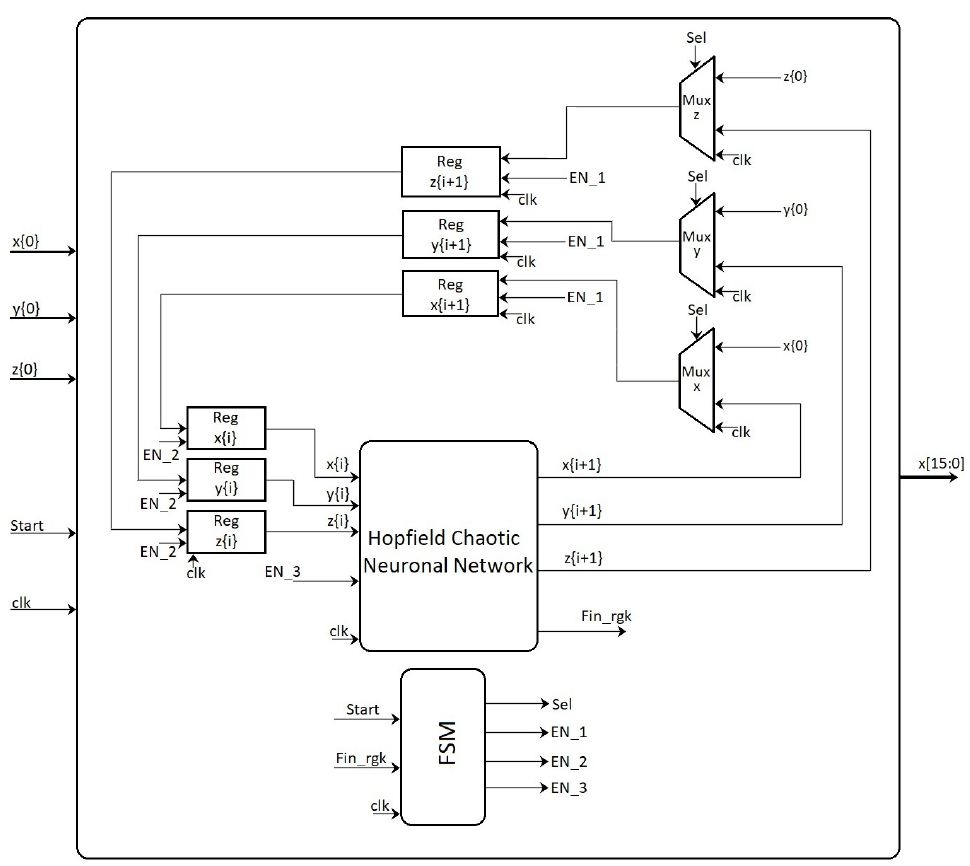
Figure 8. High-level description of the FPGA-based implementation of the Hopfield neural